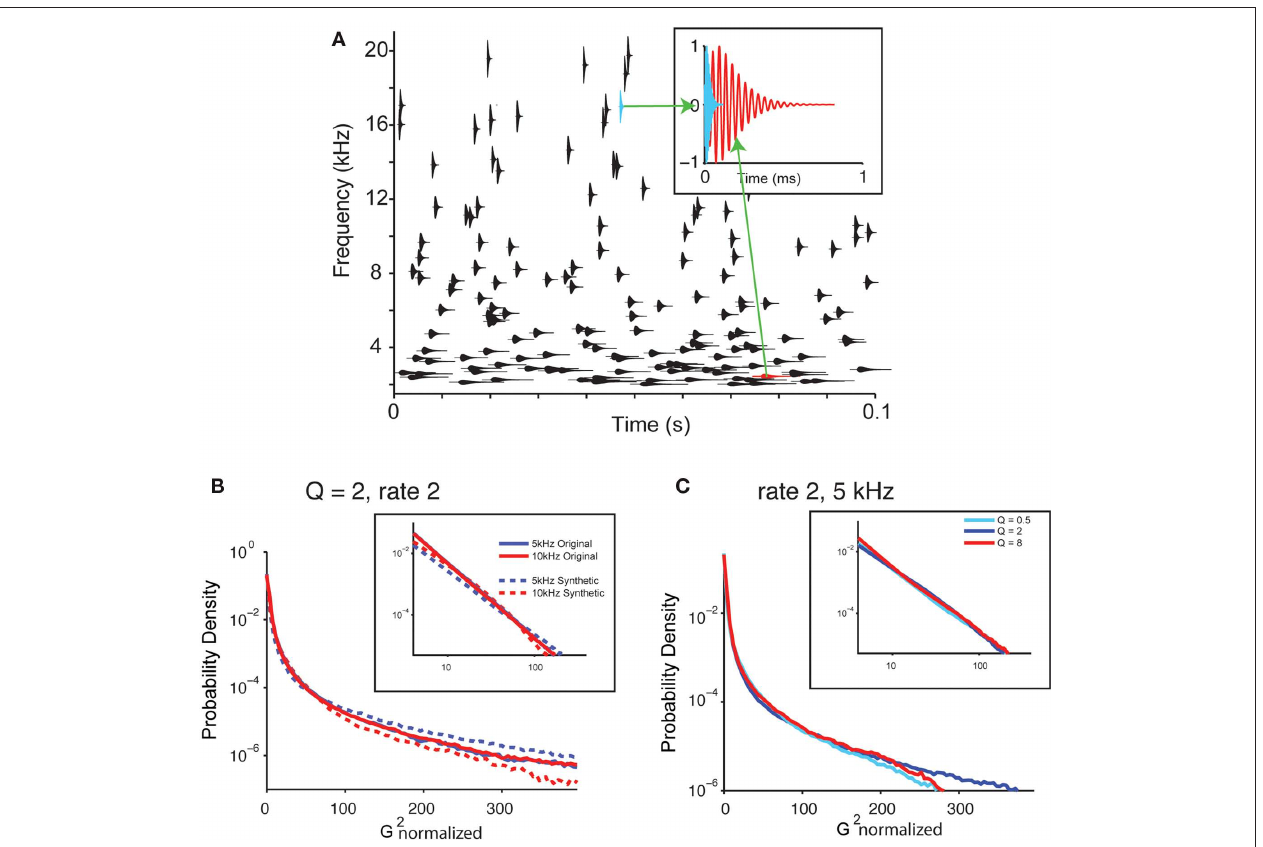
of the chirp. x -coordinate denotes its time. Top insets: shape of two characteristic chirps at different frequencies. (B) Histogram of power of gammatone transform for the original recording and the synthetic sounds ( Q = 2, rate 2; same as in Figure 3C ). (C) Histogram of power of gammatone transform for the synthetic sounds with varying Q ( Q = 0.5, 2, and 8, rate 2; same as in Figure 3C